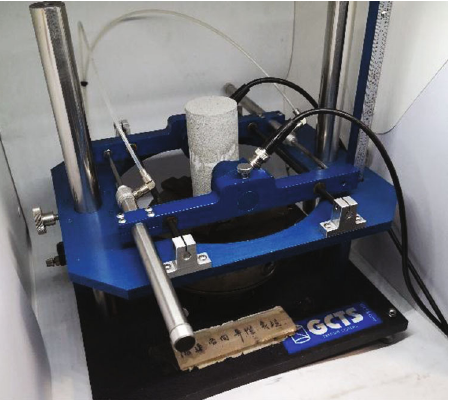
Figure 10: Ultrasonic testing system.